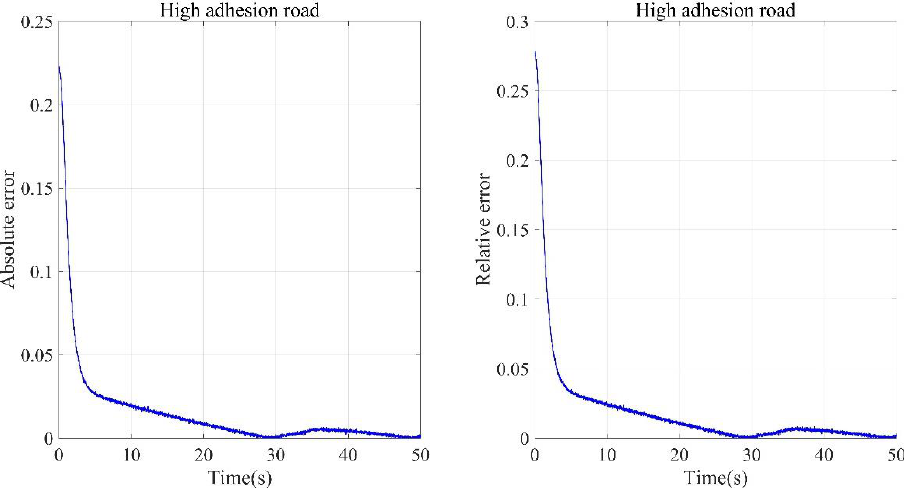
Figure 22. Error analysis of road adhesion coefficient estimation result under low-adhesion road.